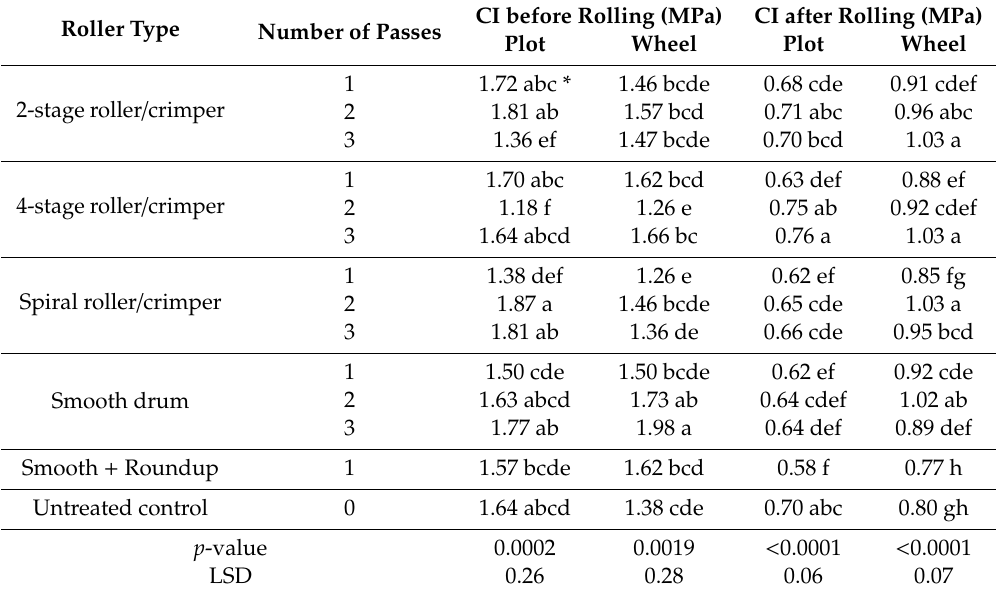
Table 11. Soil CI averaged over depth (0–30 cm) for rolling treatments in 2015 growing season. Roller Type Number of Passes